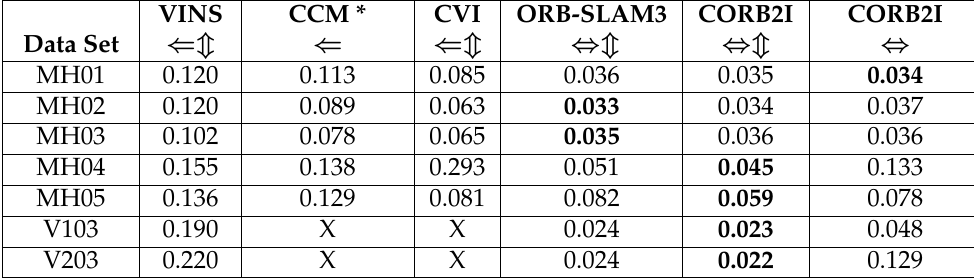
Table 1. The RMS ATE (meter) of single agent for experiments on EuRoC sequences [49]. ‘ ⇐ ’, ‘ ⇔ ’, and ‘ (cid:109) ’ indicate monocular, stereo, and IMU usage, respectively. ‘*’ indicates the trajectories are scaled off-line because the metric scale is not